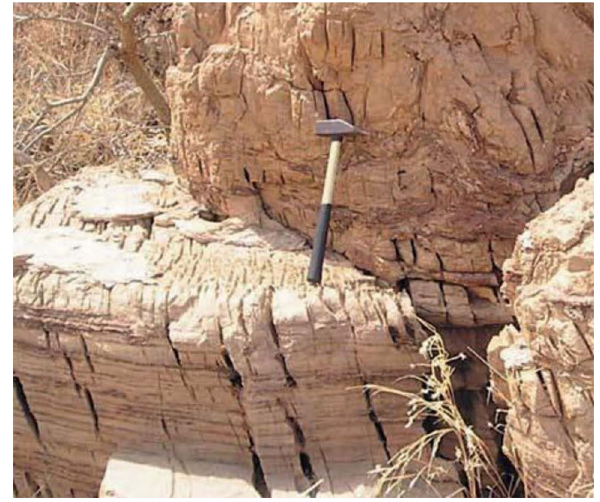
Fig. 1 Complex fracture network of a carbonate sedimentary outcrop (Whaley